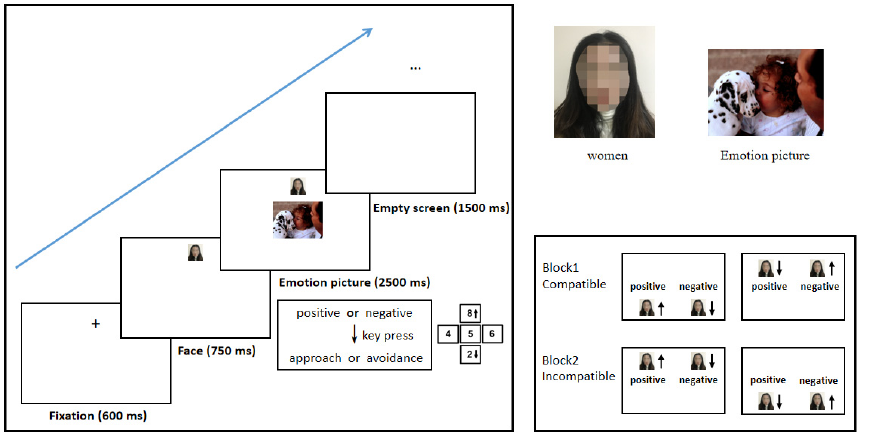
Figure 1. Experimental procedure in Experiment 1. A fixation point appeared either in the middle of the upper or the lower half of the screen for 600 ms. A self-face of the participant then appeared in the same position of the fixation point. At 750 ms after the appearance of the self-face, an emotional (positive or negative) picture was presented at the center of the screen (2500 ms). The self-face can be moved downward by pressing the “2” key and can be moved upward by pressing “8” key. Participants were instructed to move the self-face close to or away from the picture. All illustrations disappeared 500 ms after key press. The inter-trial interval was 1500 ms.